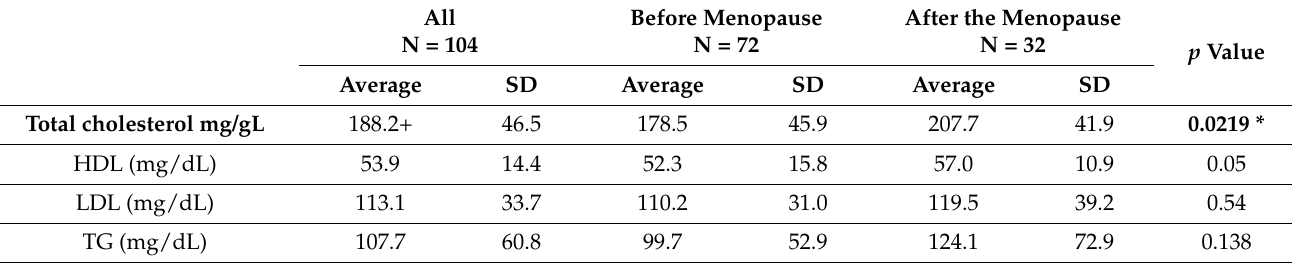
Table 4. Mean levels of lipid metabolism parameters before treatment by hormonal